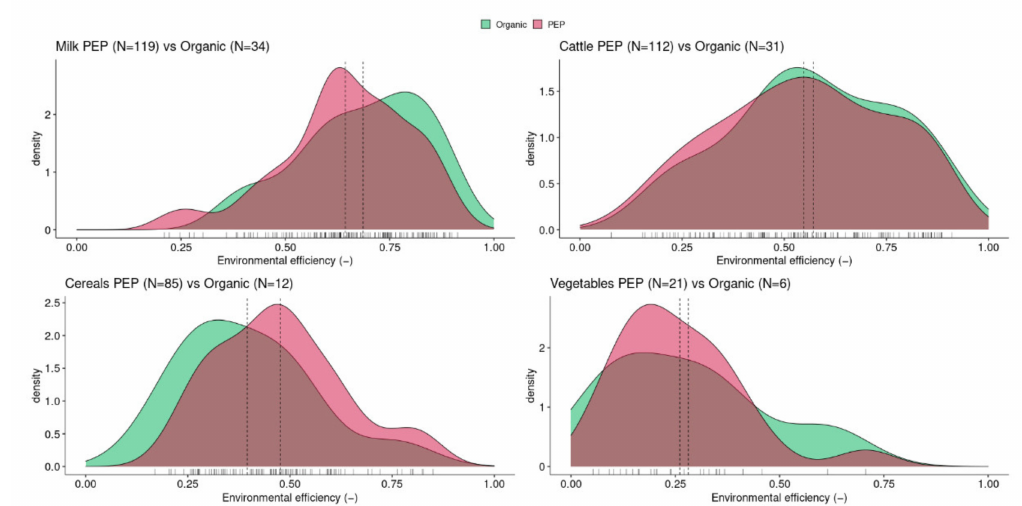
Figure 4. Distribution of environmental efficiency for product groups: Comparison of PEP (proof of ecological performance) and organic farming systems. The dotted line marks the average environmental efficiency for the product group. The tick marks below the x -axis denote actual observations.